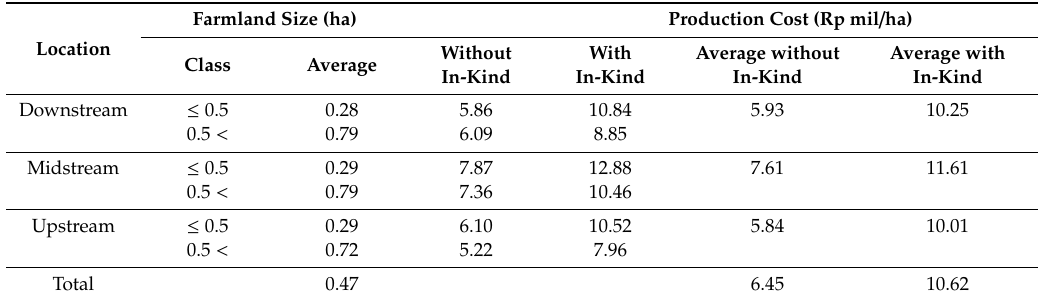
Table 3. Cost of rice production without and with in-kind by farmland size and location.